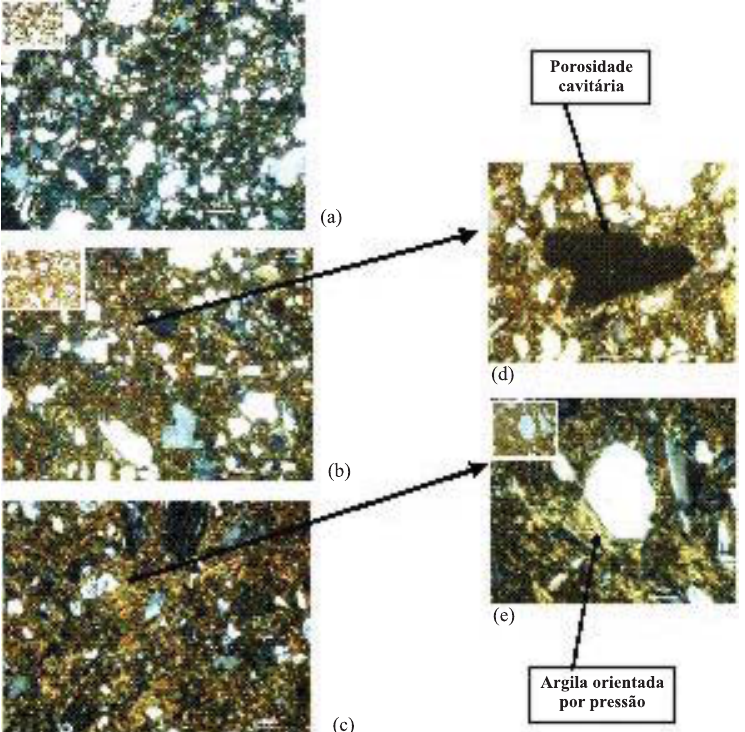
Figura 6. Fotomicrografias (XPL) dos horizontes BA, Bt1 e Bt2 do perfil P4, com detalhes sob luz PPL: (a) fundo matricial do horizonte BA com trama porfírica de espaço simples; (b) fundo matricial do horizonte Bt1 com trama porfírica de espaço simples; (c) fundo matricial do horizonte Bt2 com trama porfírica fechada; (d) poros do tipo cavidade observada no horizonte Bt1; (e) fábrica birrefringente do horizonte